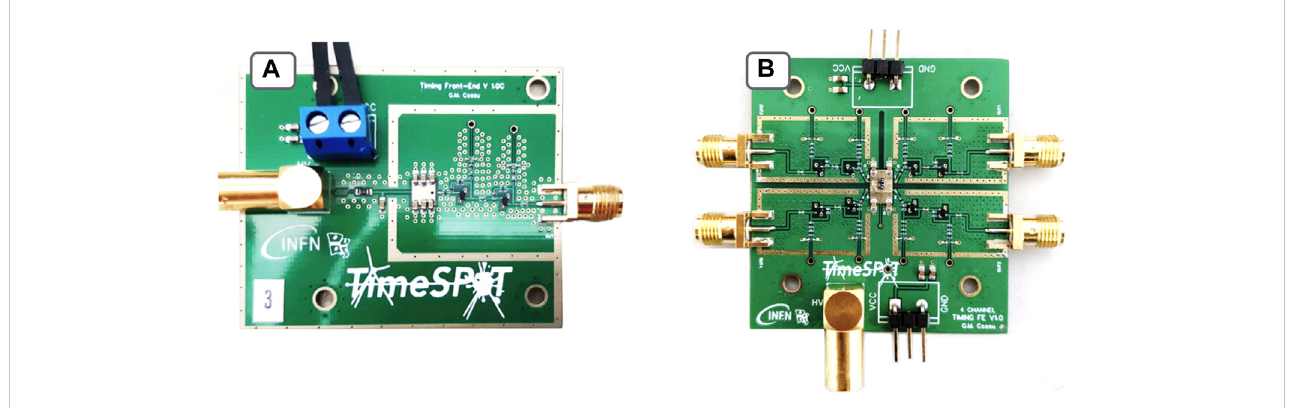
FIGURE 3 Thefront-endboardsusedinthiswork: (A) single-channeland (B) four-channelversions.Thesensorstobereadoutareattachedwithconductivetapeto the large metal pad at the board center and the readout electrodes are wire bonded to the input pad of the fi rst stage of the ampli fi er. The large metal pad provides the bias to the sensor under